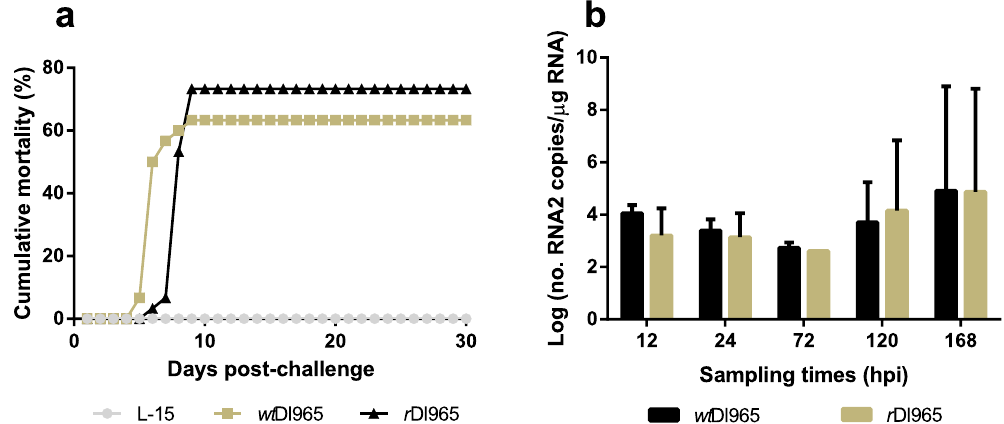
Figure 2. Comparative analysis of wt Dl965 and r Dl965 virulence. ( a ) Accumulated mortality. ( b ) Viral genome quantification in European sea bass brain. Viral genome was quantified by RT absolute real-time PCR. The t-student test was used to compare the number of RNA2 copies in fish from different experimental groups within each sampling time. Values of p < 0.05 were considered significant. Results are mean ± s.d. (n =